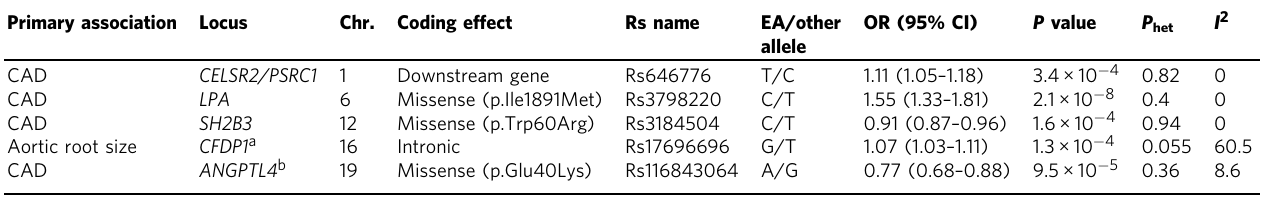
Table 3 Coronary artery disease variants and aortic root size variants that associate with aortic valve stenosis Primary association